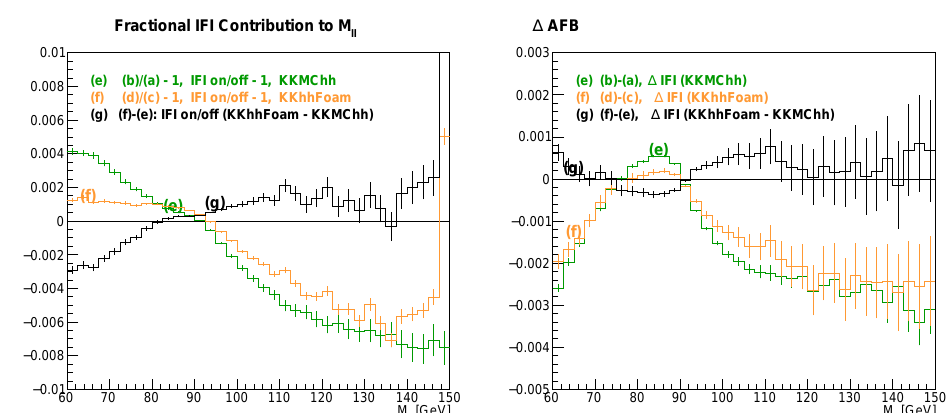
Figure 2: Lepton mass distribution and charge asymmetry from KKMChh and KKhhFoam . The figure on the left shows the fractional contribution to M for both KKMChh and KKhhFoam . The figure on the right shows the absolute contri- bution of IFI to A . The black curves on the right are the differences between the FB KKhhFoam and KKMChh curves in each